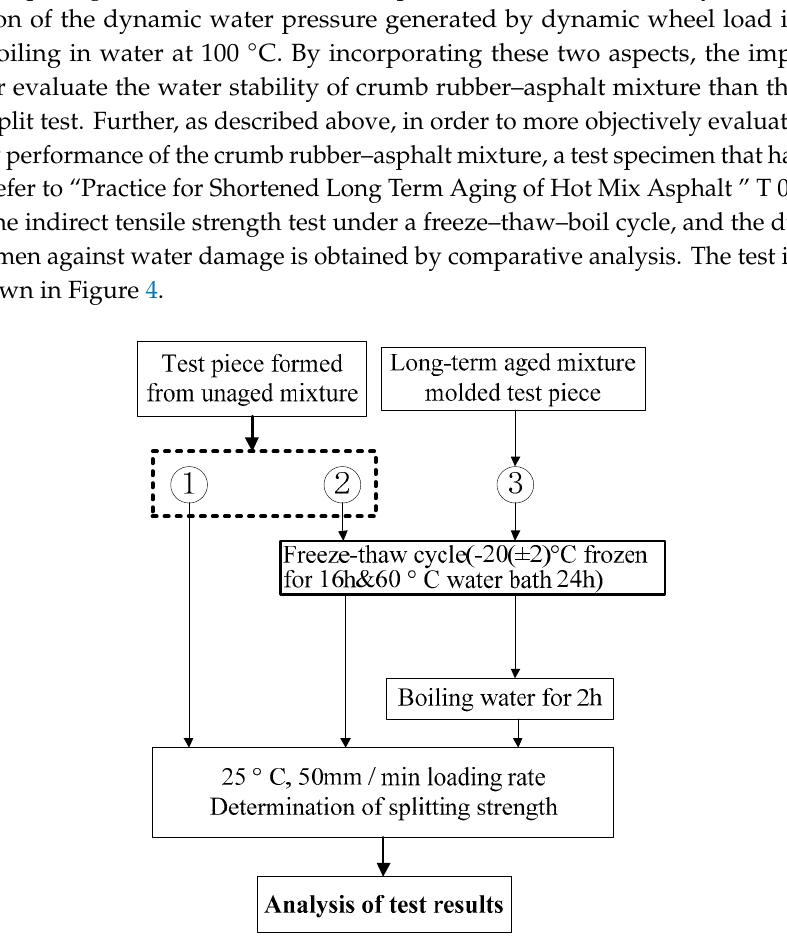
Figure 4. Schematic illustration of the test process.